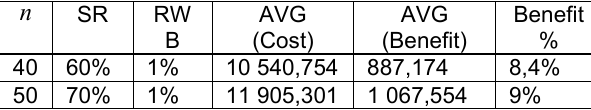
Table 3. Results for 5 N =